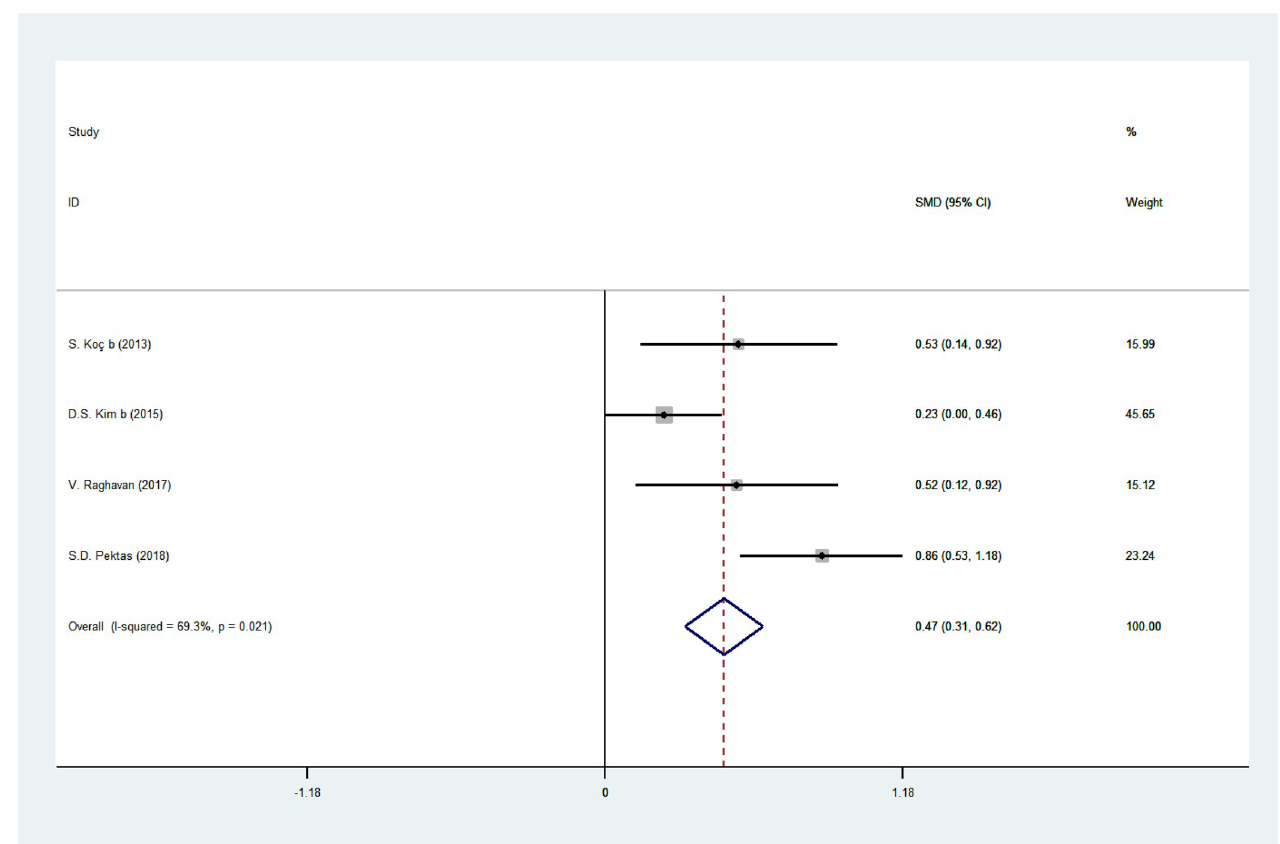
Fig 7. Forest plot of RDW values and the presence of